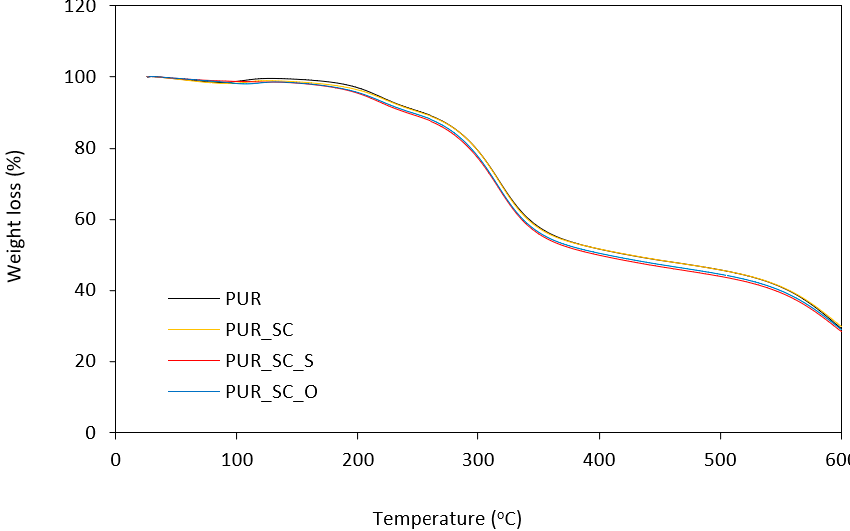
Figure 5. TGA curves obtained for PUR foams modified with sunflower cakes.